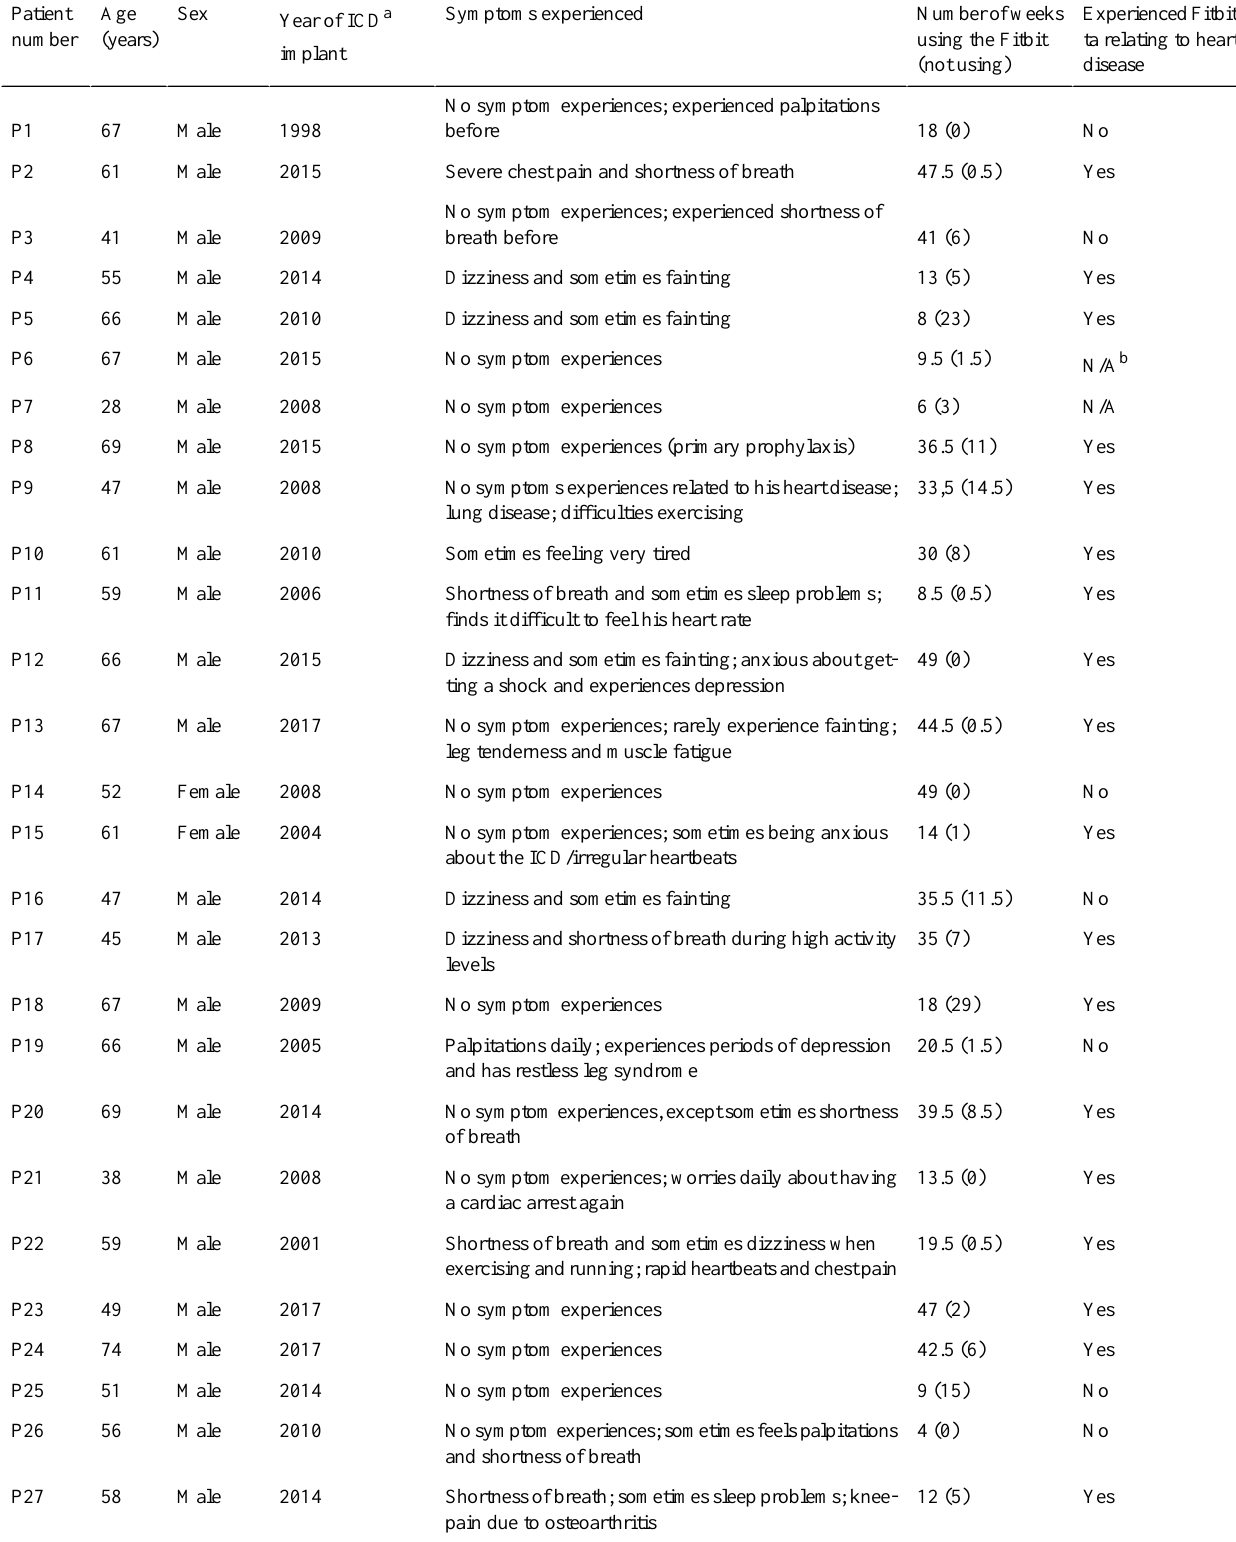
Table 1. Overview of participating patients with chronic heart disease and an implantable cardioverter-defibrillator